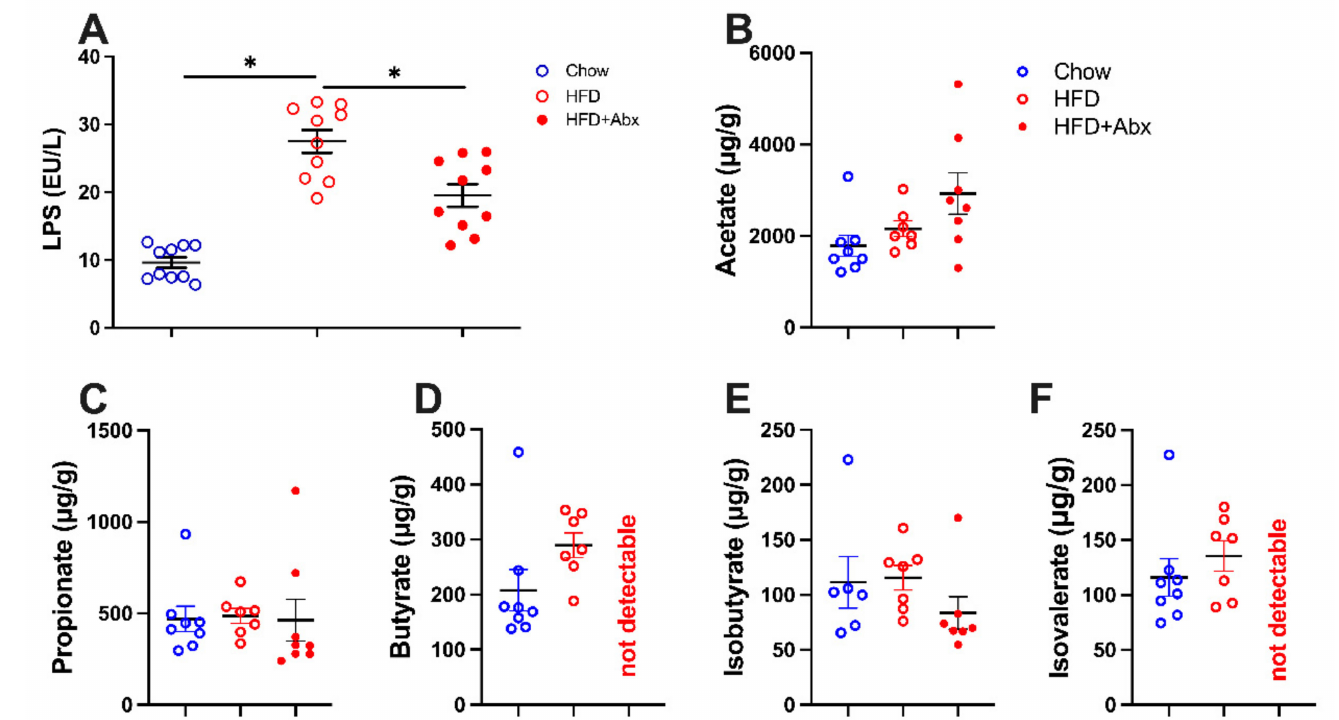
Figure 3. Gut microbiota depletion decreased the serum LPS and fecal SCFA content. ( A ) Serum LPS level; ( B ) fecal acetate content; ( C ) fecal propionate content; ( D ) fecal butyrate content; ( E ) fecal isobutyrate content; ( F ) fecal isovalerate content. Data were expressed as the mean ± SEM. * p < 0.05.